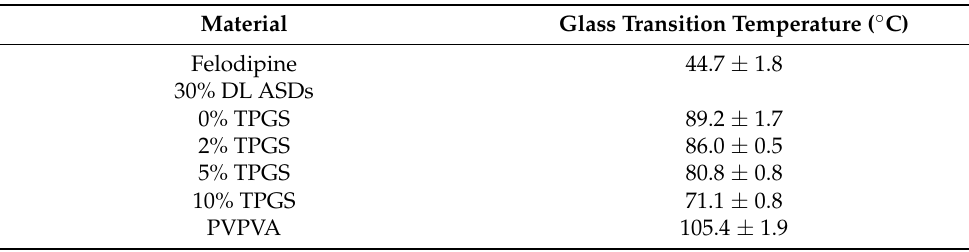
Table 2. Glass transition temperature for amorphous felodipine, PVPVA, and 30% DL felodipine- PVPVA ASDs at different TPGS levels (0%, 2%, 5%, and